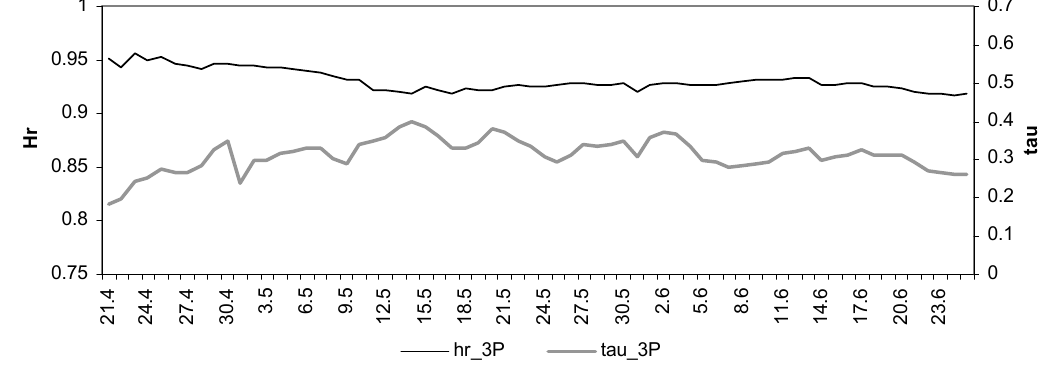
are free parameters. Soil moisture r )_vwc). Two different r parameterized as a function of soil r